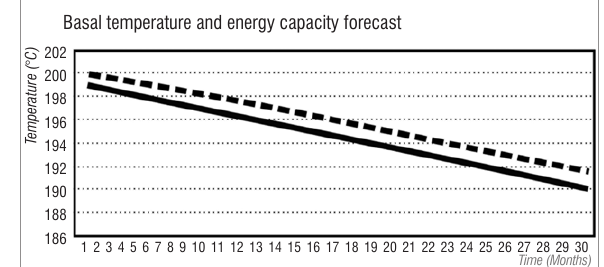
Figure 10: Graph forecasting the decrease in basal reservoir temperature (dashed curve) and the consequential decrease in energy production (solid curve) of a hypothetical enhanced geo- thermal system.